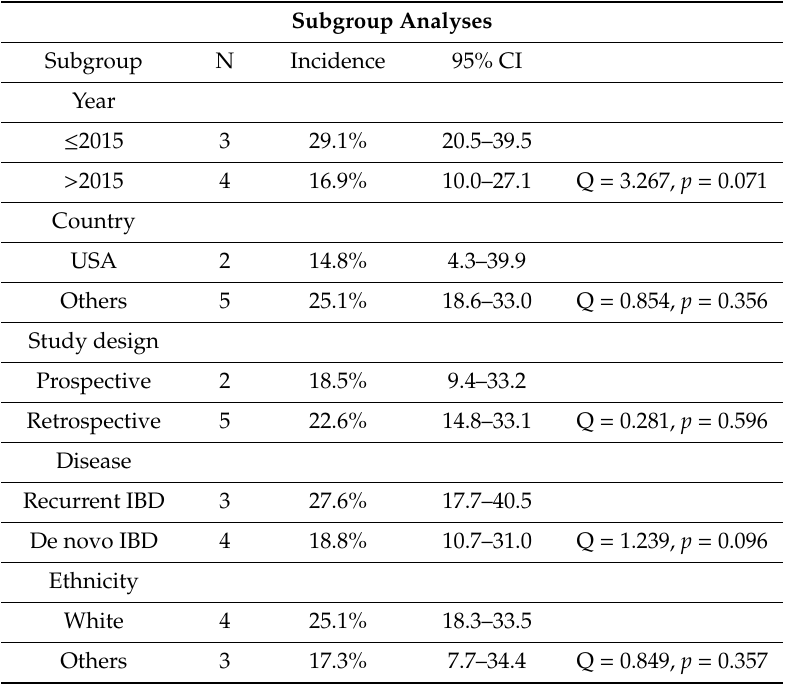
Table 2. Subgroup analyses.